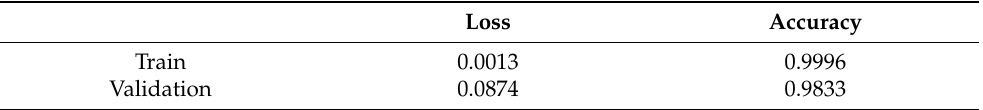
Figure 12. Training results. As the number of epochs increases, the accuracy and loss of both Train/Validation converge, which shows that learning has been successfully achieved. Table 2. Loss and accuracy at the end of